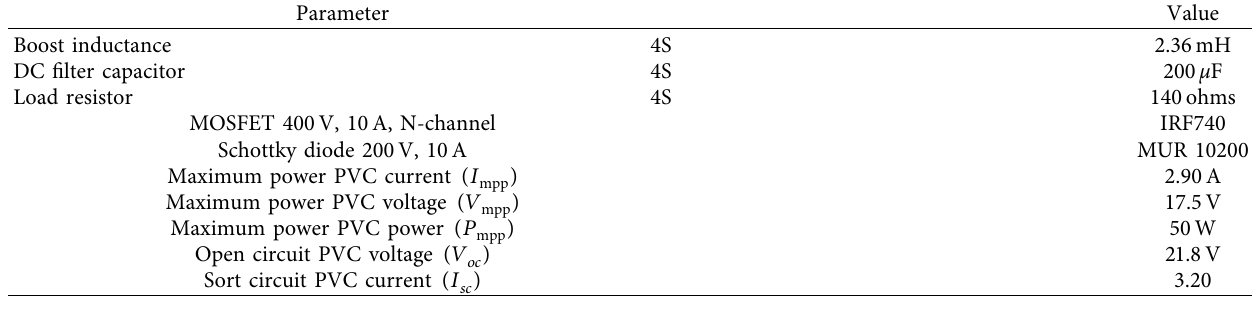
Table 2: Hardware parameter values of 4S confguration.